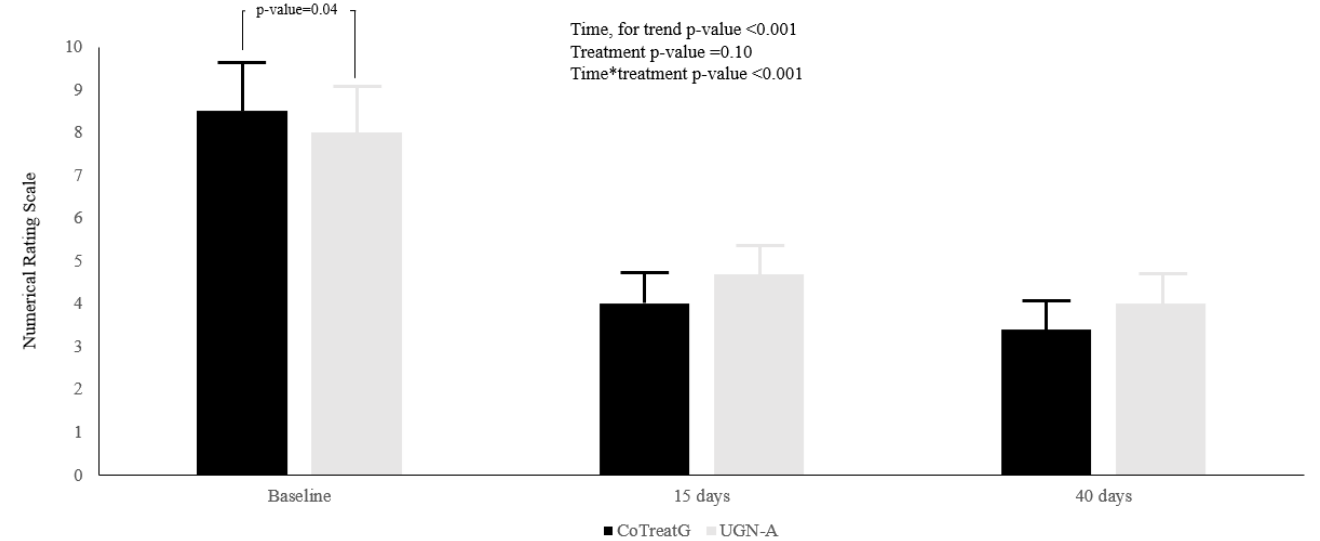
Figure 2. Visual Analogue Scale score was reported as mean ± S.E. In black histograms the UGN plus BEN treatment group (CoTreatG) is represented, whereas in gray histograms the UGN-alone treatment (UGN-A) is represented. The differences between treatments were assessed with Linear Mixed Models, and were reported by the p -value for: Time, Treatment and the interaction between Time × Treatment.